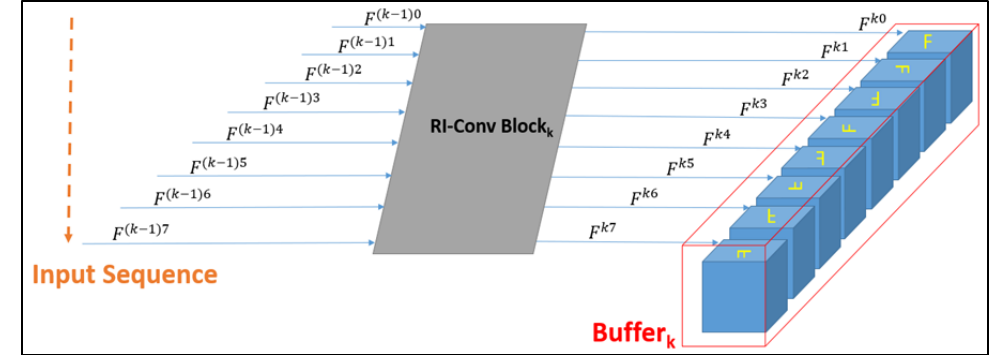
Figure 8. Buffer architecture following a RI-Conv block.